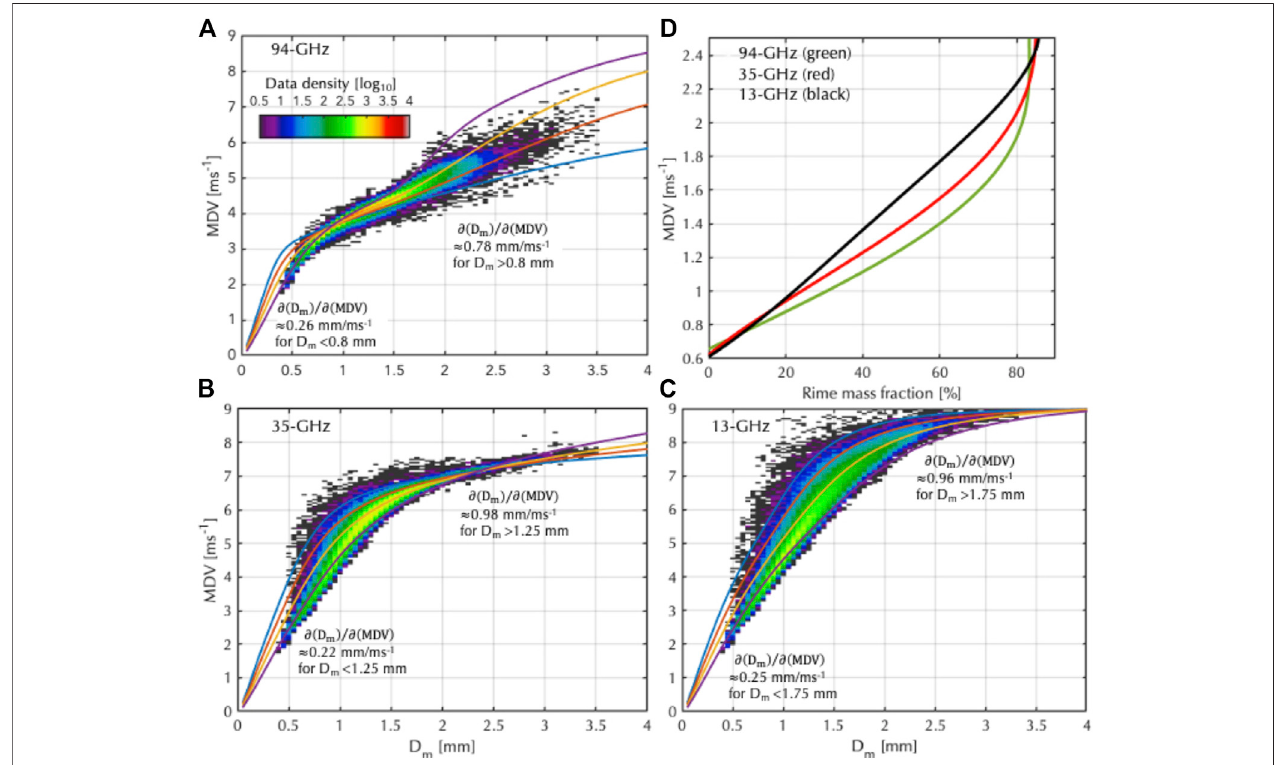
FIGURE 8 | (A) For a 94-GHz radar, relationships between raindrop particle size distribution (PSD ’ s) mean volume-weighted diameter (D m ) and mean Doppler velocity(MDV)fromground-basedmeasurements(colormap)andfromdifferentMDV-D m relationshipsderivedforagammadistributionfordifferentshapeparameter ( μ ) values (colored lines). (B) Same as “ a ” for a 35-GHz radar. (C) Same as “ a ” for a 13-GHz radar. (D) relationship between rime mass fraction and mean Doppler velocity (MDV) from literature based on studies performed with a 94 GHz (green), 35 GHz (red) and 13 GHz radar (black).